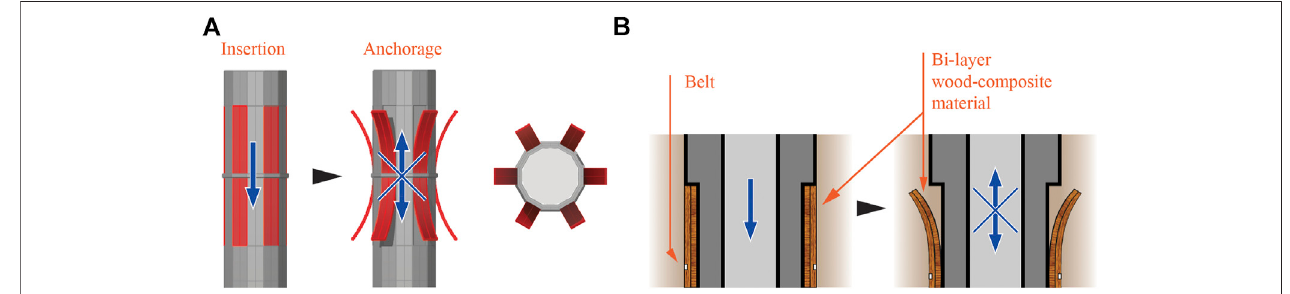
FIGURE 8 | Shape-change foundation based on bi-layer materials — The smooth foundation pile is driven into the soil (A-left) . Over time, the bi-layer composite material,exposedtohumidity, curvesoutwardsresultinginincreasedanchoragethroughfriction (A-middle),(A-right) presentsatopviewofthisdeployedpilesystem. (B-left and right) show the disposition of the bi-layer composite material and the belt holding it in place, before and after the curvature change.